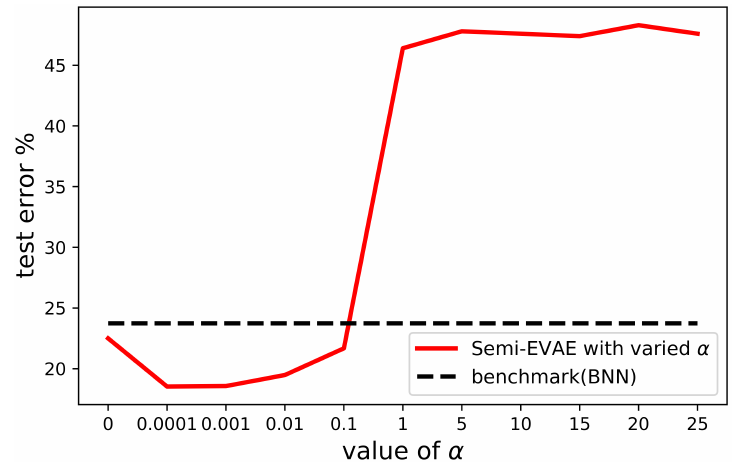
Figure 4. Effect of α on discriminative performance of semisupervised EVAE. This figure demonstrates the classification performance of 11 versions of a semisupervised EVAE on the CIFAR-10(4K) dataset. Note that the benchmark model (a fully supervised Bayesian neural network) was implemented in a similar model architecture as the scaffolding encoder that is detailed in Table